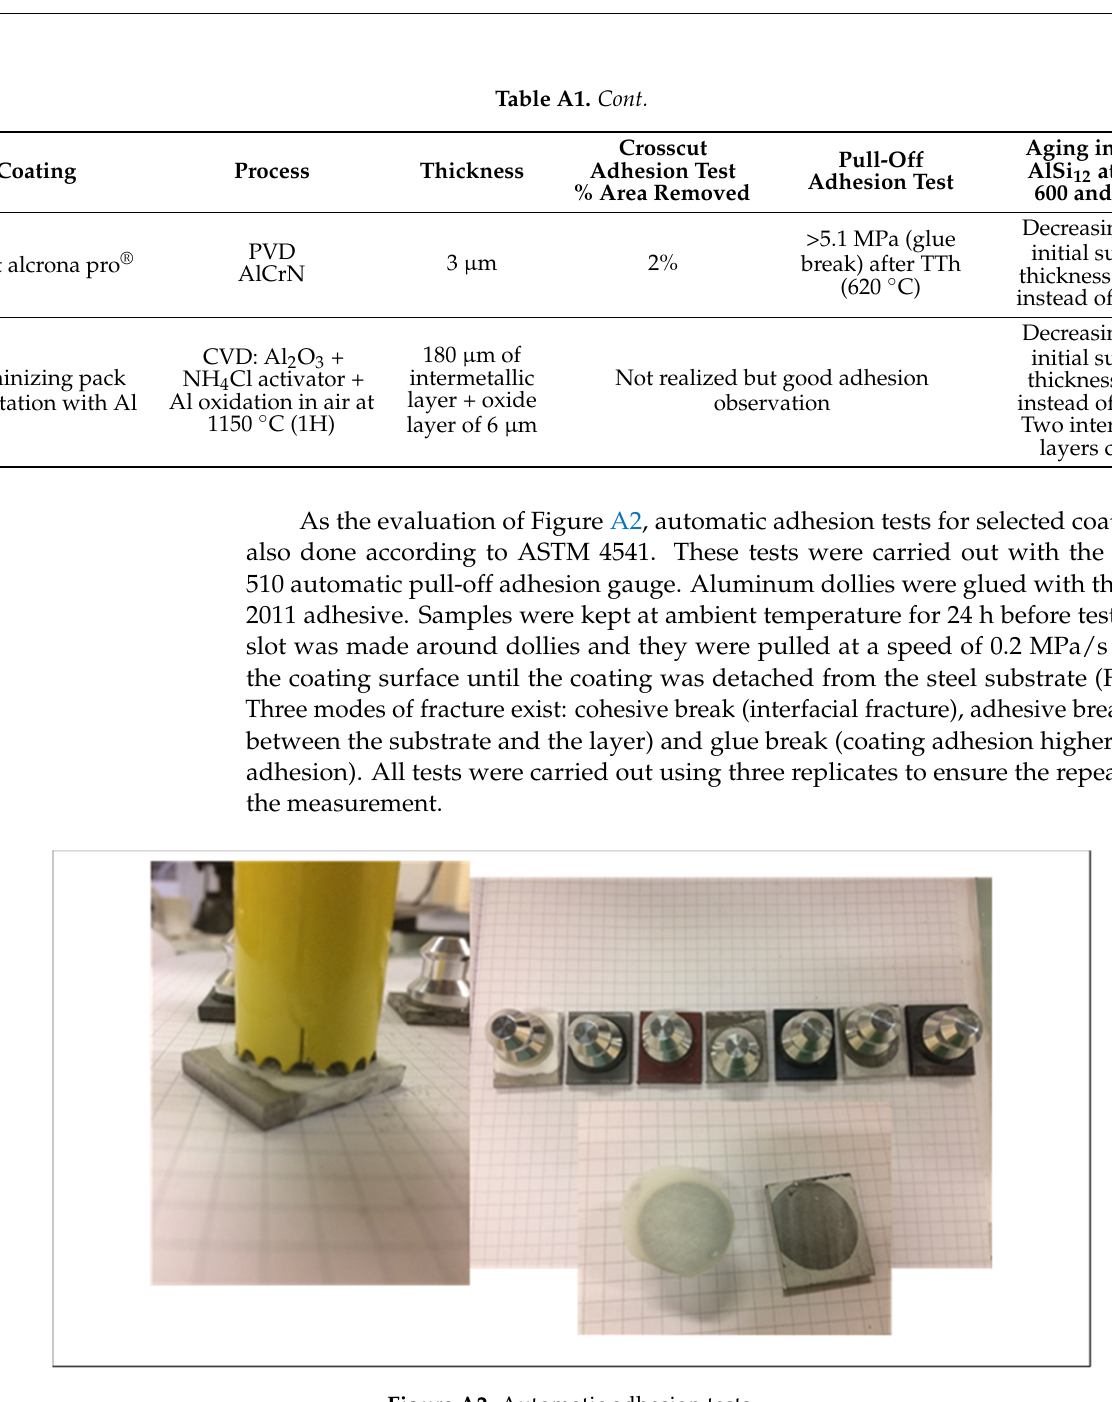
Figure A2. Automatic adhesion tests.